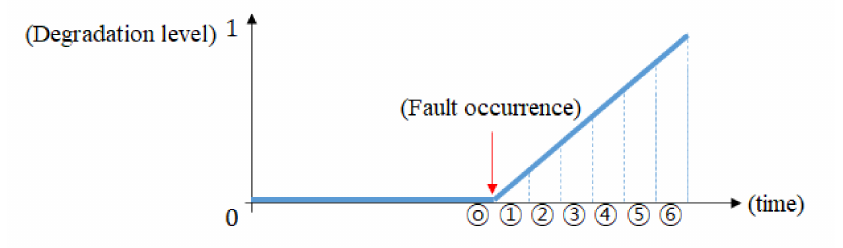
Figure 2. Used degradation model for